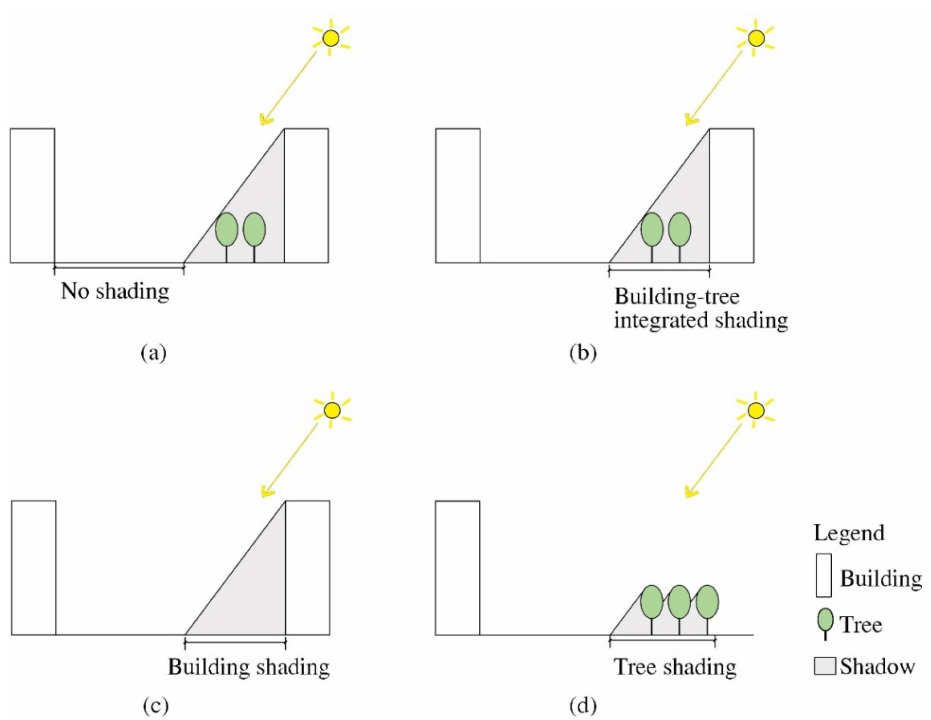
Figure 1. No shading ( a ), building–tree integrated shading ( b ), building shading ( c ), tree shading ( d